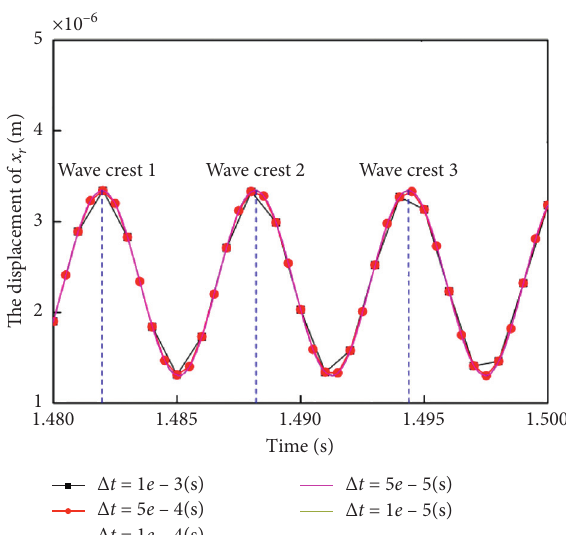
Figure 7: The amplitude of wave crests with different calculation